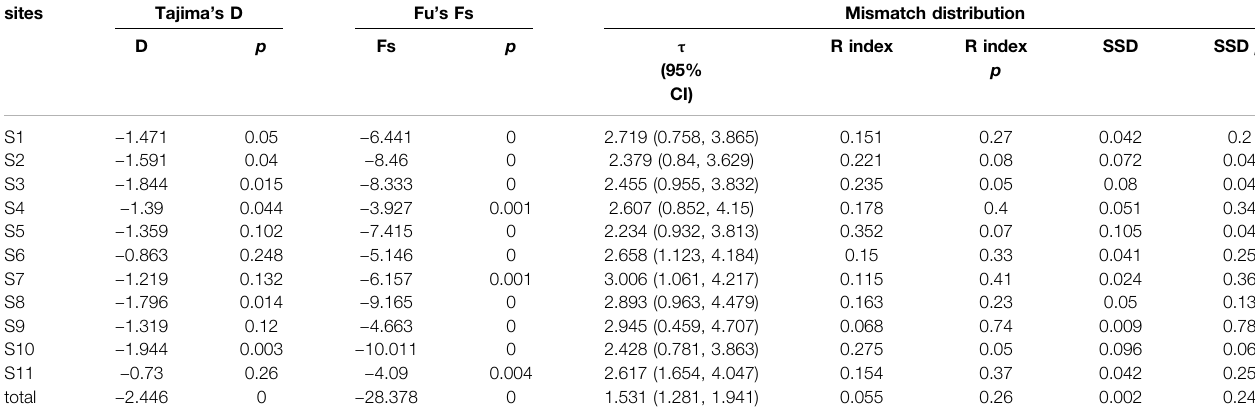
TABLE 4 | Mismatch distribution, Tajima ’ s D and Fu ’ s Fs statistics for Evynnis cardinalis . sites